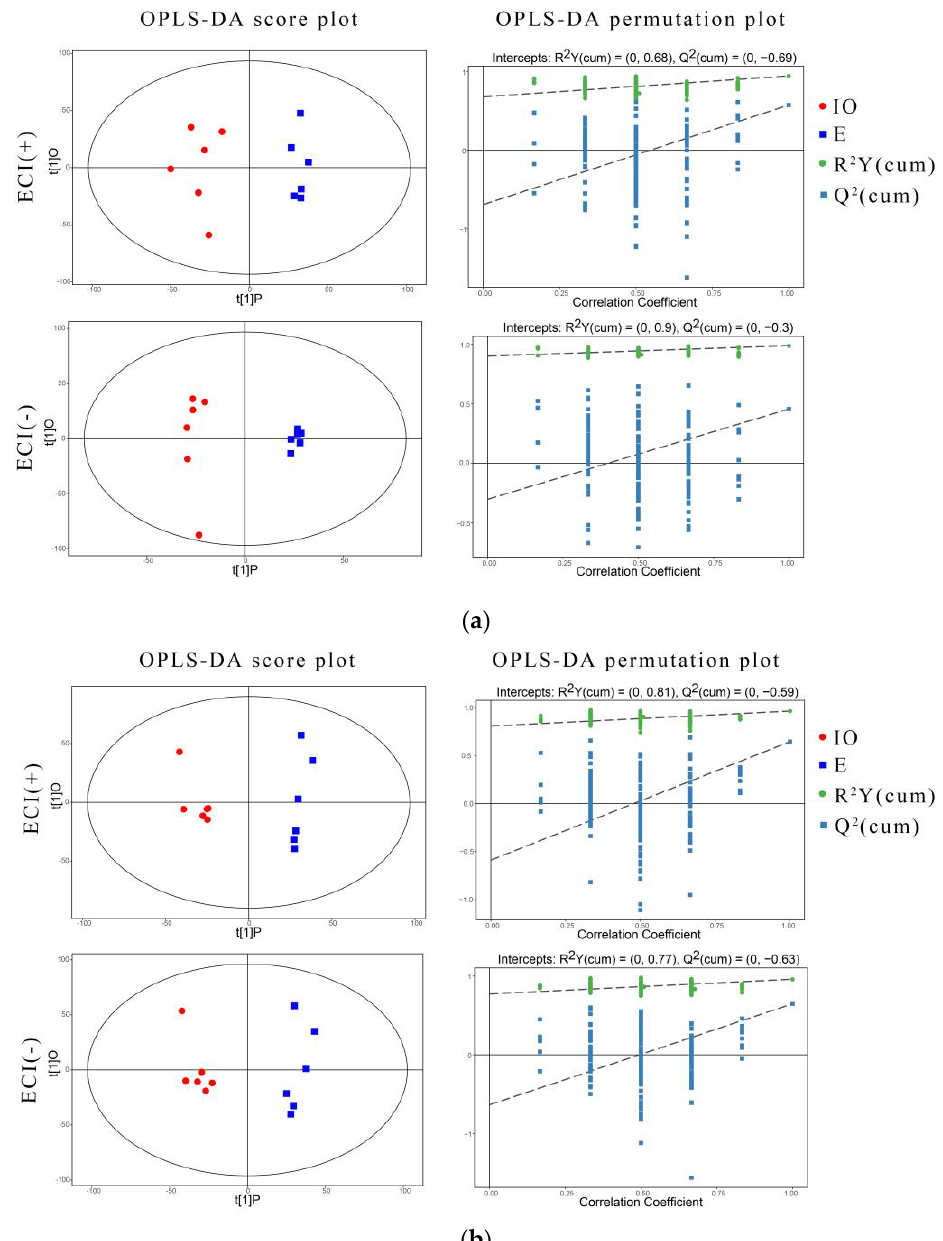
Figure 1. OPLS-DA model analysis of the E group versus the IO group in positive and negative ion mode in serum ( a ) and follicular fluid ( b ) samples. The prediction score of the first principal component of the scatter plot is the abscissa, the orthogonal principal component score is the ordinate, red is the E group, and blue is the IO group. In the OPLS-DA permutation plot, the permutation retention rate is the abscissa, the value of R 2 Y or Q 2 is the ordinate, the blue dot is the Q 2 value, the green dot is the R 2 Y value, and the dotted line is the regression line.